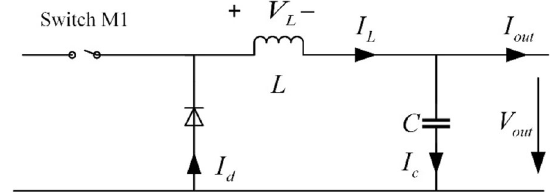
Fig. 4 Electrical Model of DC/DC Buck